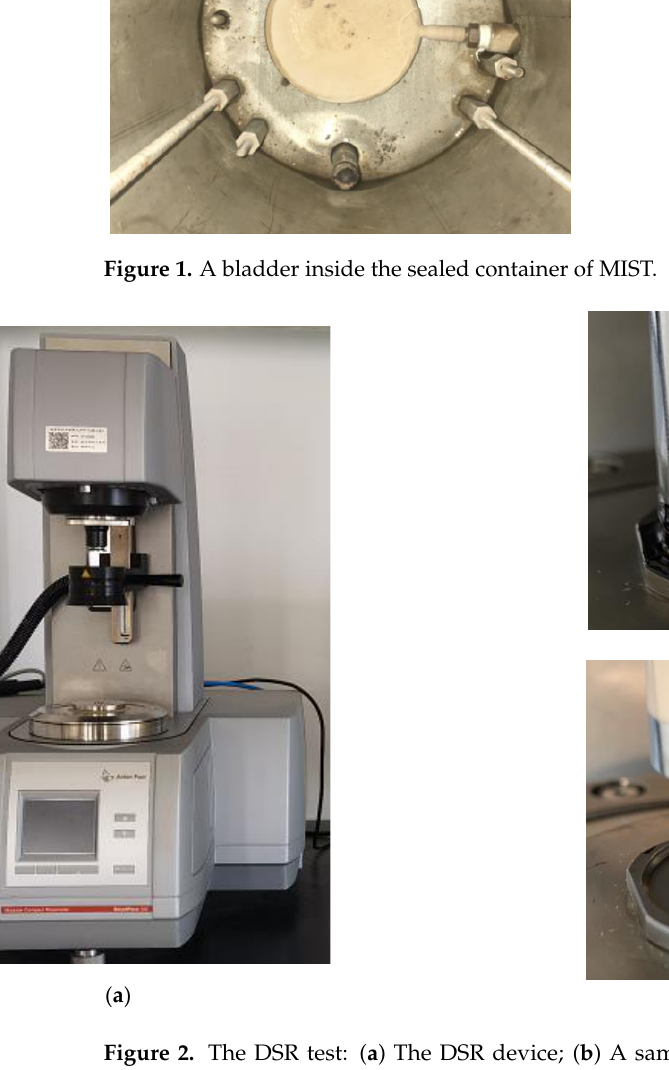
Figure 1. A bladder inside the sealed container of MIST.